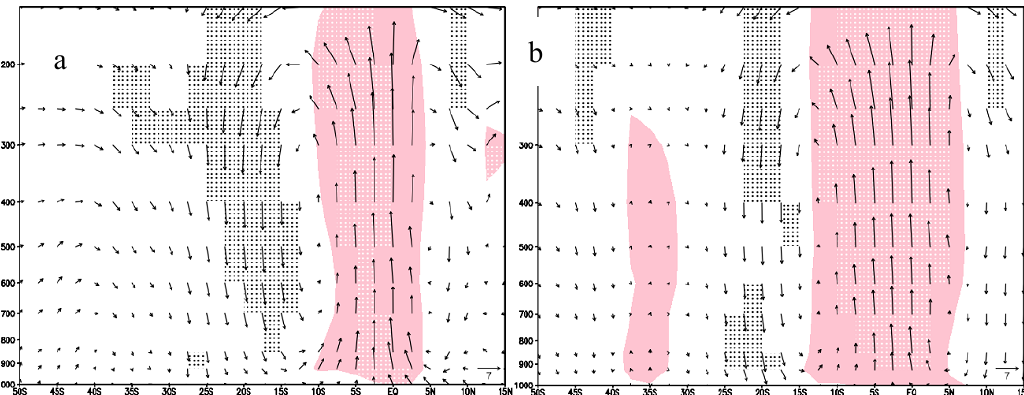
Figure 7. Composite anomalies of latitude–pressure cross-sections of meridional circulations (vectors) averaged along 170° E–170° W during DJF 1980–2017 for austral autumn ( a ) and winter ( b ) El Niño events. The units for meridional wind and vertical motion are m·s − 1 and hPa·s − 1 , respectively. The values of vertical velocity are multiplied by − 300. Shaded areas have an upward vertical velocity of ≥ 0.01 hPa·s − 1 . Dotted areas indicate statistically significant vertical velocity at the 95% confidence level, based on the Student’s t -test.